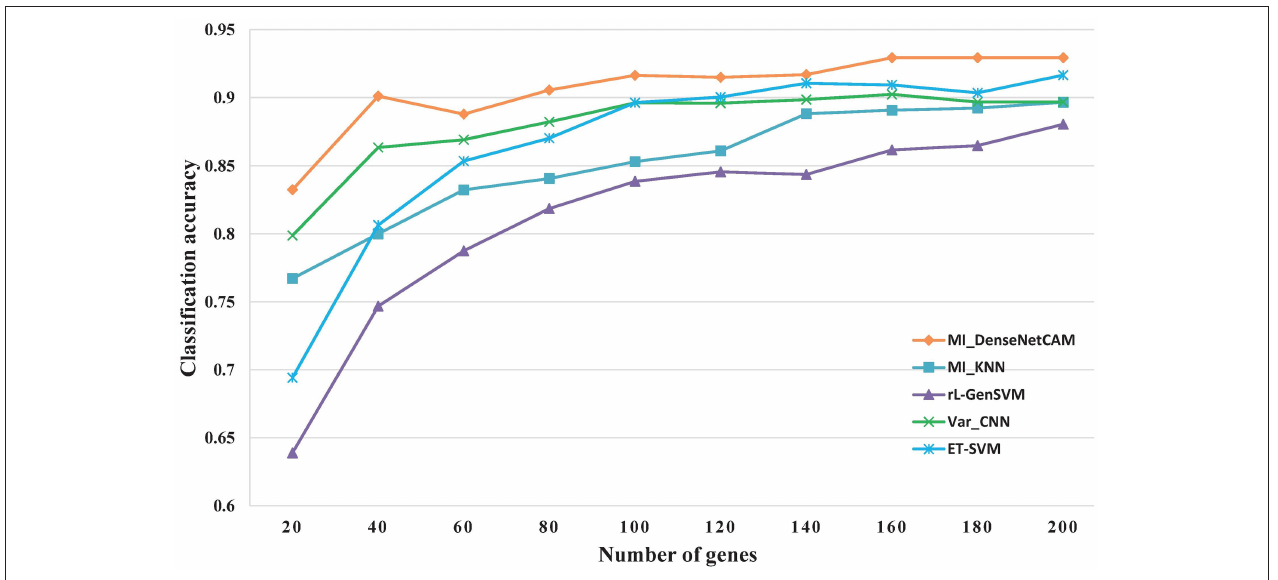
FIGURE 3 | The Classification accuracy of different gene numbers.